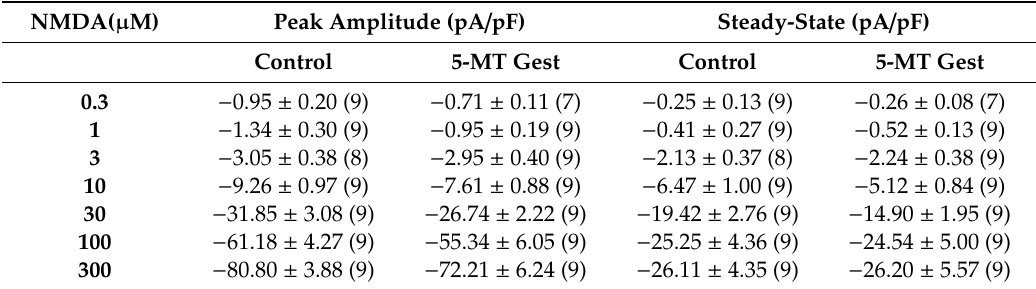
Figure 4. Effect of 5-HT (30 µ M) on I Glut and I NMDA . The 5-MT treatment caused a significant increase of the 5-HT inhibitory effect of the peak amplitude ( A ) of both I Glut (t − 3.52 = 7.64, p = 0.008) and I NMDA (t − 3.74 = 8.15, p = 0.005) relative to the control group. The SS ( B ) presents a similar increase in both currents (I Glut : t 6.43 = − 2.59, p = 0.04; I NMDA : t 5.09 = − 3.07, p = 0.02). Conversely, the inhibition caused by 5-HT in I Glut and I NMDA in the same cell presents no statistically significant difference between them neither on peak amplitude (Control, t 4 = 0.52, p = 0.63; 5-MT Gest, t 5 = 0.24, p = 0.82) or SS (Control t 4 = −0.19, p = 0.86; 5-MT t 5 = 0.7153, p = 0.51). ( C ) Representative traces of I Glut and I NMDA both in the presence and absence of 5-HT in the same cell. Significance codes: p < 0.001 (***), p < 0.01 (**), p < 0.05 (*). Table 2. Peak amplitude and steady-state of currents from each NMDA